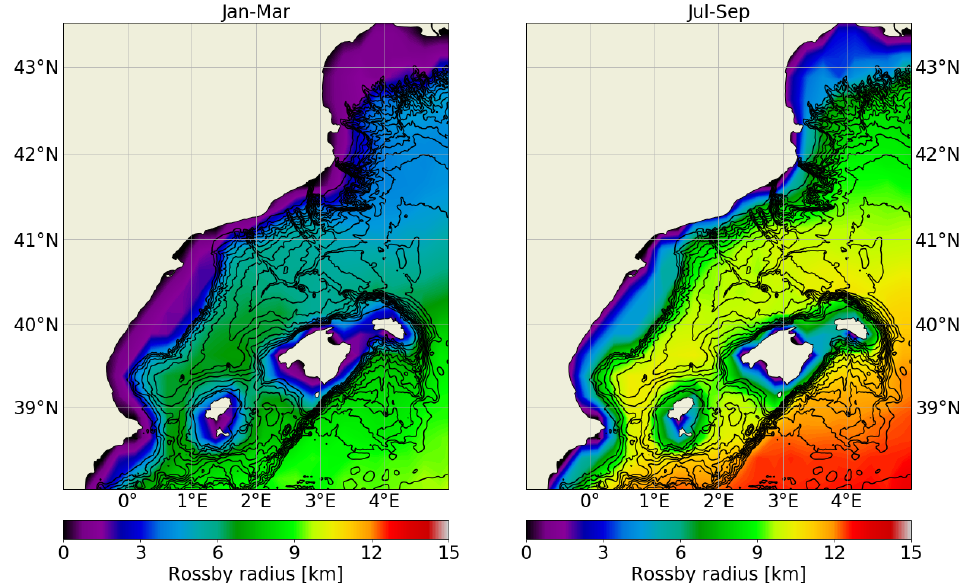
Figure 4. Rossby radius estimated from the World Ocean Atlas (2018) using the approximation provided by Chelton et al. [39] for January–March ( left ) and July–September ( right ). Solid black lines correspond to bathymetric lines drawn every 200